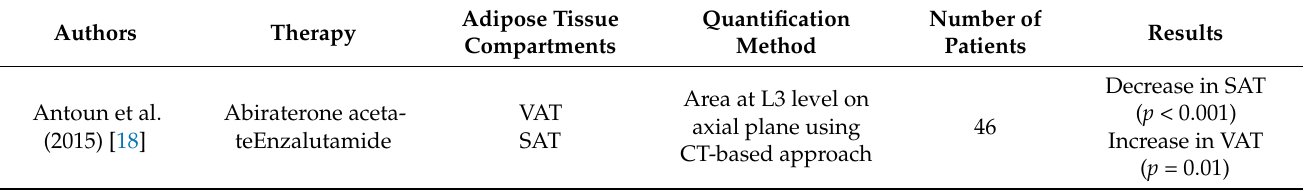
Table 1. Summary of data and results of CT and MRI studies with quantification of adipose tissue